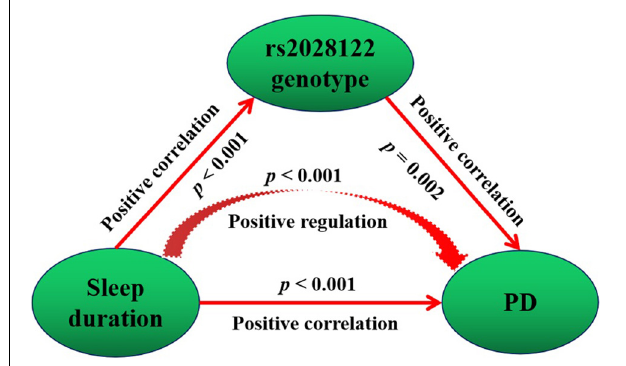
FIGURE 3 | Mediating causality of the RORA rs2028122 in the causal path of sleep duration leading to PD. Mediation model suggests that the rs2028122 genotype partially mediates the causal path of sleep duration leading to development of PD on positive